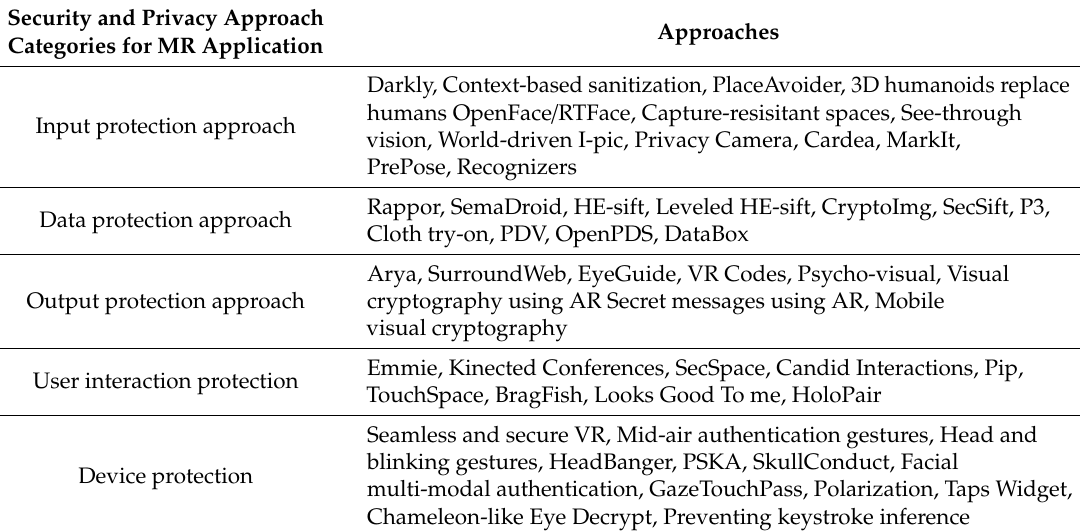
Table 3. Security and privacy approach for MR